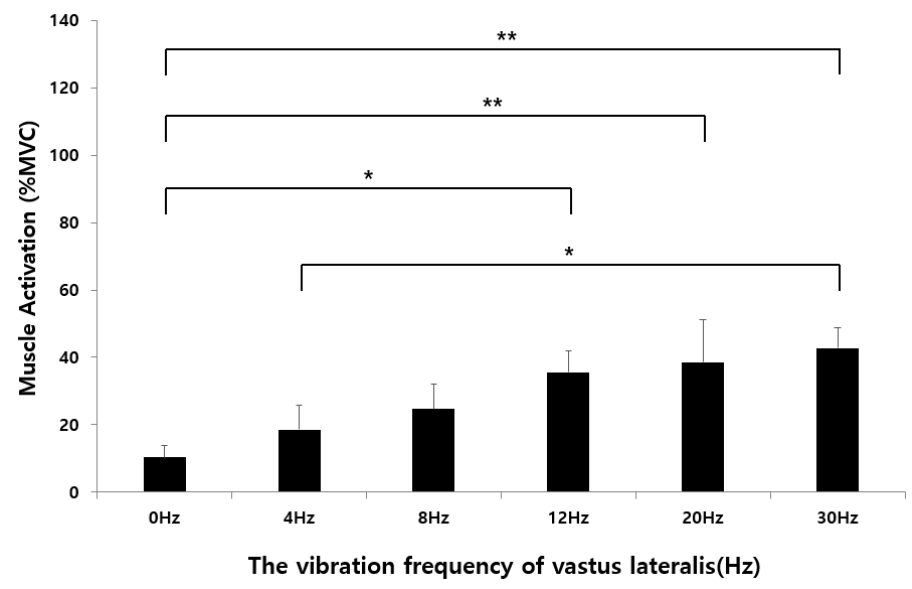
Figure 7. Results of vastus lateralis muscle activation according to the vibration frequency conditions. (* p < 0.05, ** p < 0.01).